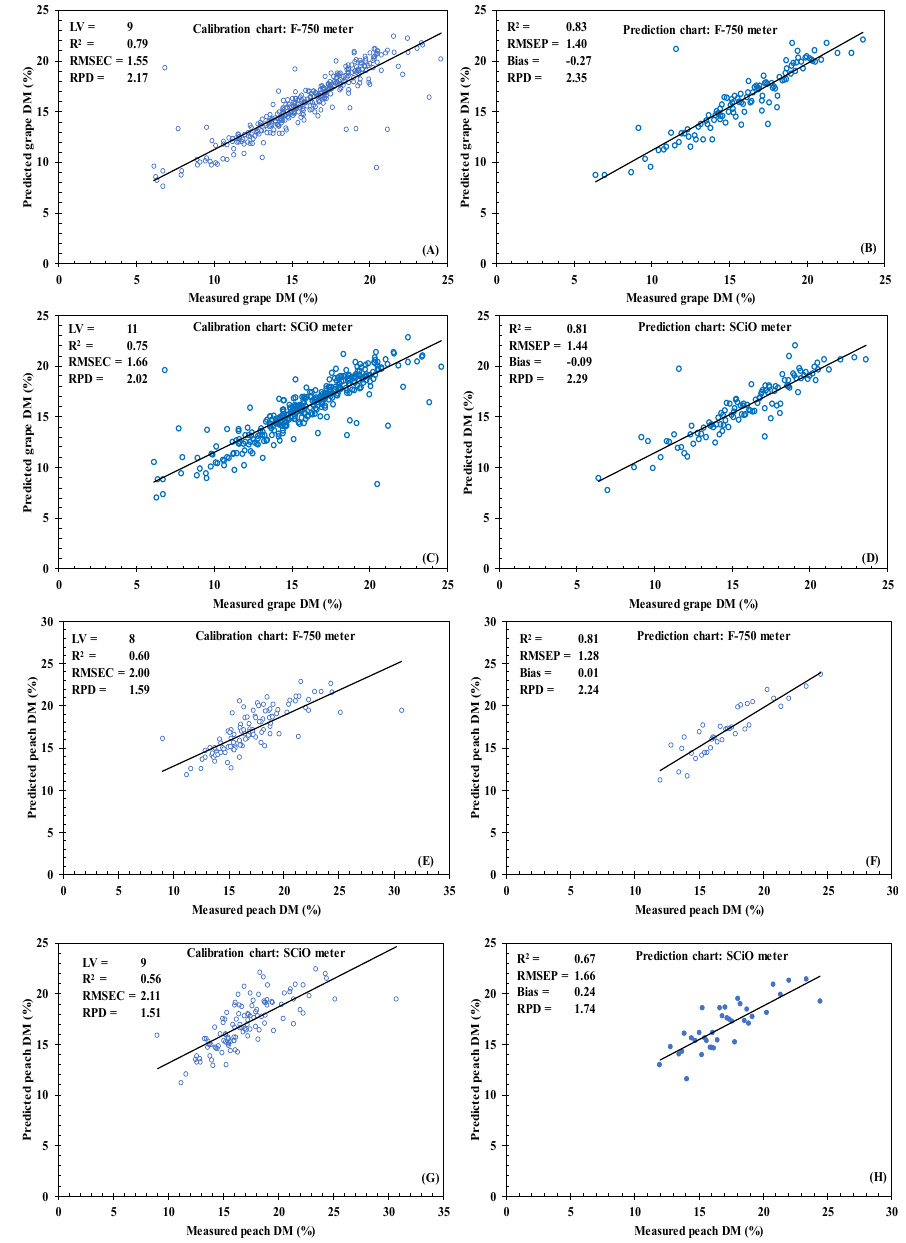
Figure 4. Scatter plot of measured versus predicted dry matter (DM) values of table grapes ( A – D ) and peach ( E – H ) calculated using the best PLSR calibration model for the F-750 and SCiO spectrometers. The black line represents the linear correlation between the measured values obtained from the reference quality attribute and their prediction by the model. LV = latent variables, R 2 = coefficient of determination, RMSEC = root mean squared error of calibration, RMSEP = root mean squared error of prediction, RPD = performance to deviation ratio.